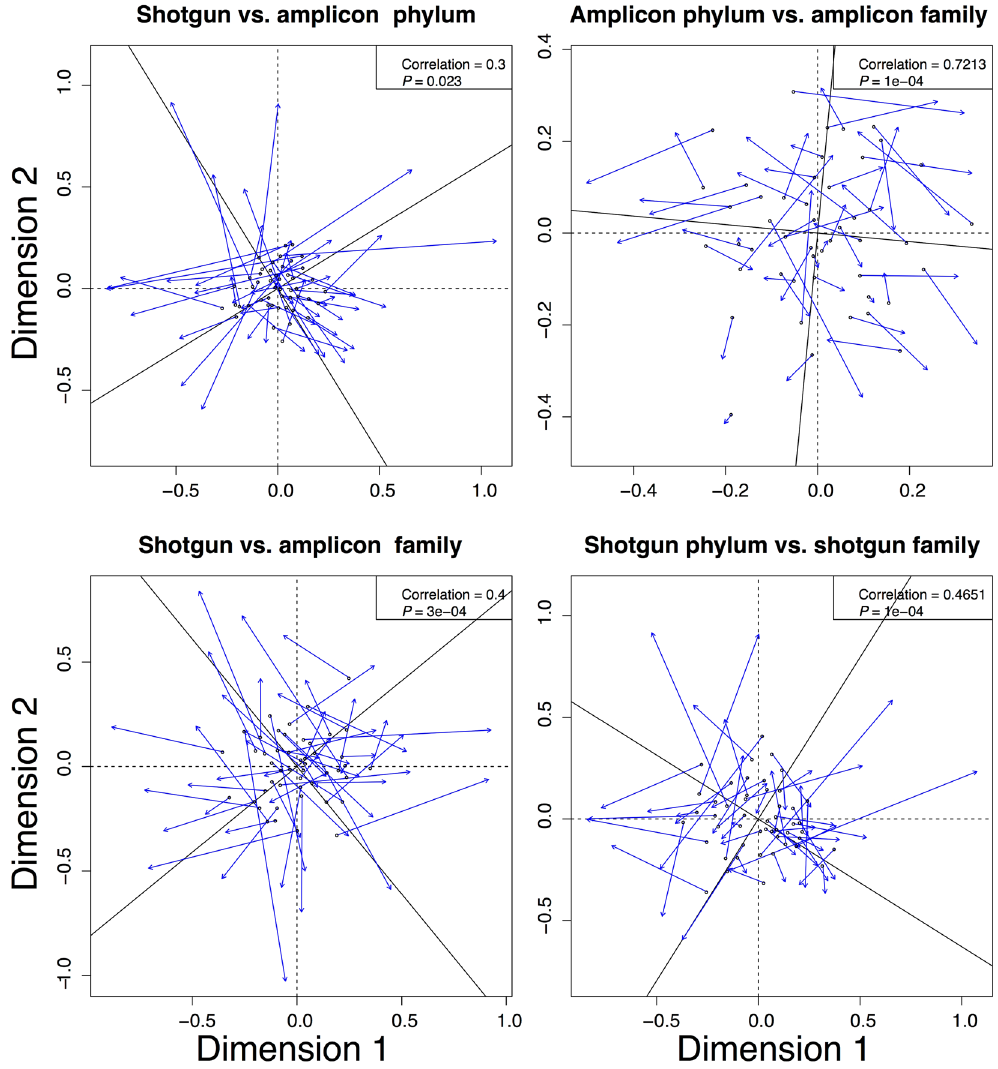
Figure 6. Procrustes visualizations of NMDS plots compared at the phylum and family levels for the amplicon vs. shotgun approaches, as well as comparisons of amplicon or shotgun at both taxonomic levels. Test statistics for Procrustes tests are presented for each